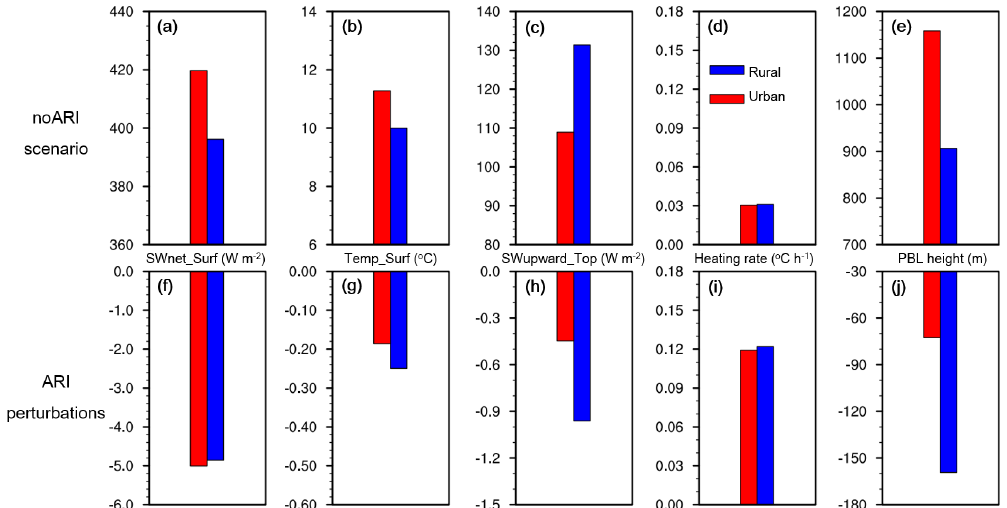
Figure 8. Net downward shortwave radiation at surface (SWnet_Surf), surface temperature (Temp_Surf), upwelling shortwave radiation at model top (SWupward_Top) and shortwave heating rate, PBL height for urban and rural underlying surfaces without aerosol effect (a–e) , and their corresponding perturbations due to aerosol–boundary layer interaction (f–j) .